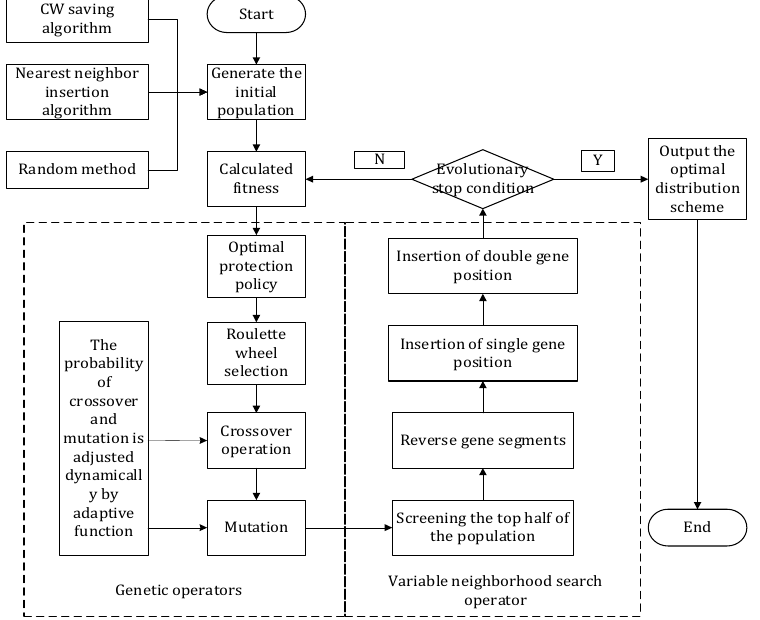
Figure 3. Algorithm flow chart.